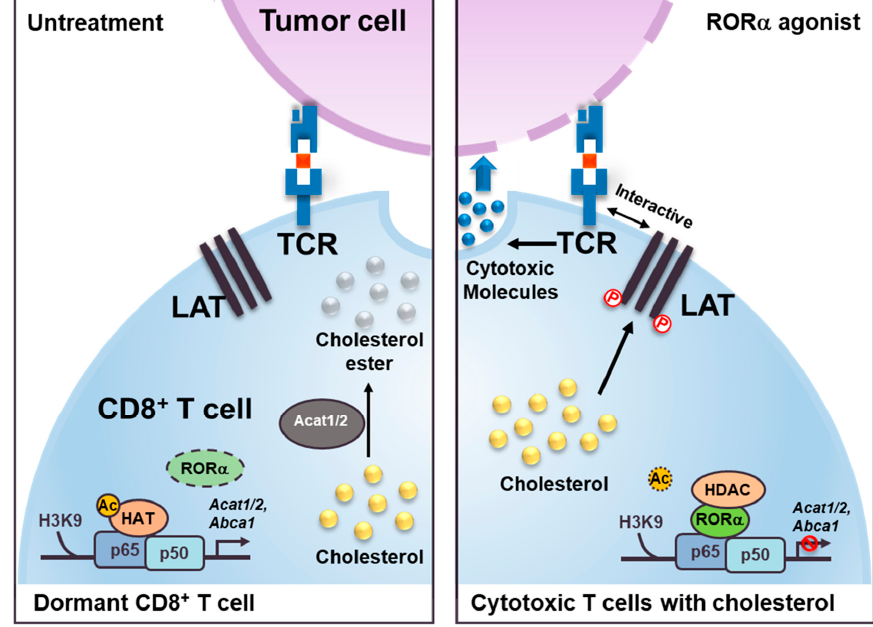
Figure 5. Schematic models show ROR α agonist effect as inducing cholesterol metabolism in cytotoxic T cells. The models illustrate the role of ROR α in CD8 + cytotoxic T cells. ROR α agonist attenuates NF- κ B signaling via HDAC recruitment on the Acat1/2 and Abca1 promoters for changing the status of T cells from dormant (left) to cytotoxic (right). These increased levels of cholesterol in the cell membrane of cytotoxic T cells induce a clustering of TCRs that interact with the antigens presented on the membrane of the cancer cells. Increased levels of cholesterol in cytotoxic T cells also trigger phosphorylation (P) of the linker of activated T cells (LAT), which, with TCRs, functions to stimulate the formation of immunological synapses.